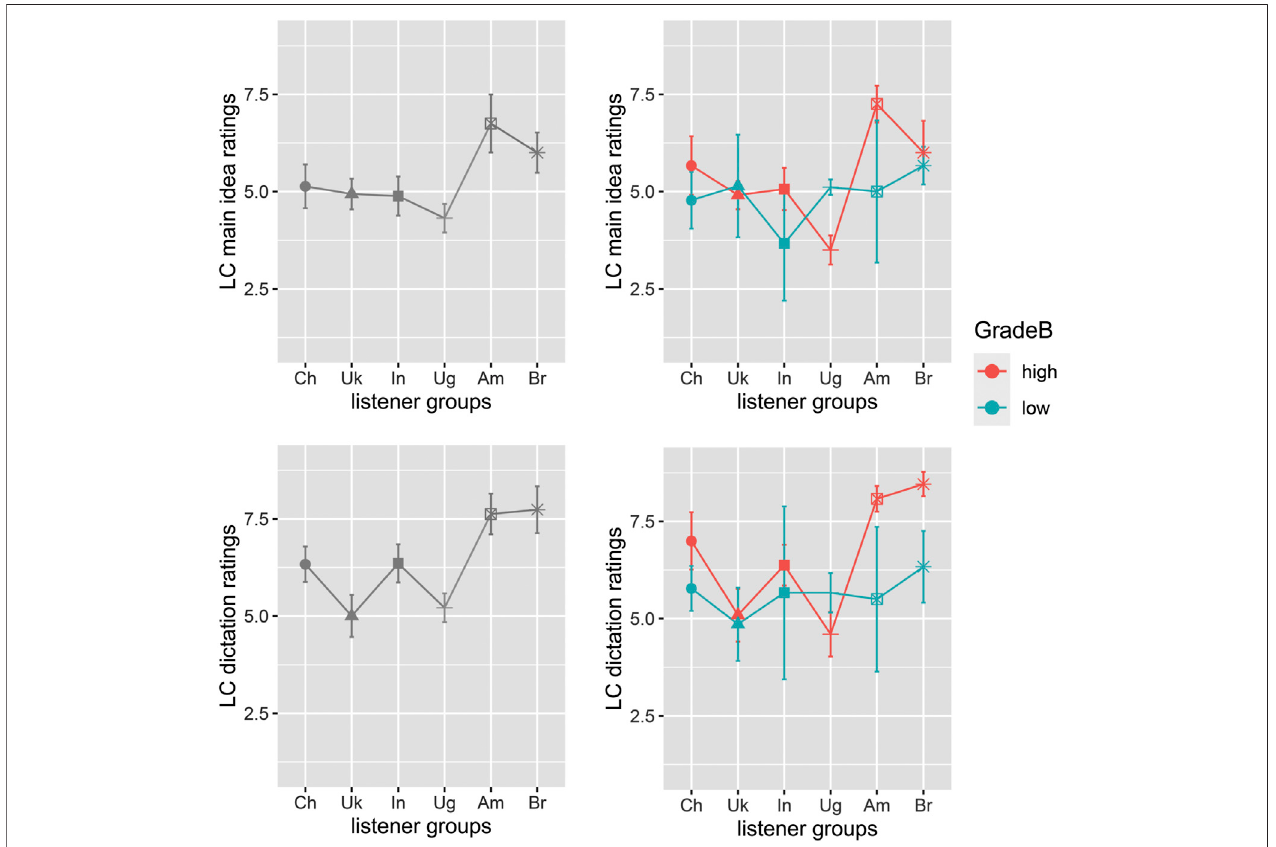
FIGURE 2 | Listener comprehensibility groups (left) and groups*English grades (right) plots using 20% trimmed means and standard errors: Note. Subject numbersare:Ch (cid:1) 23(high (cid:1) 10andlow (cid:1) 13),Uk (cid:1) 26(high (cid:1) 17andlow (cid:1) 9),In (cid:1) 27(high (cid:1) 24andlow (cid:1) 3),Ug (cid:1) 29(high (cid:1) 14andlow (cid:1) 15),Am (cid:1) 26(high (cid:1) 20and low (cid:1) 6), Br (cid:1) 29 (high (cid:1) 19 and low (cid:1)